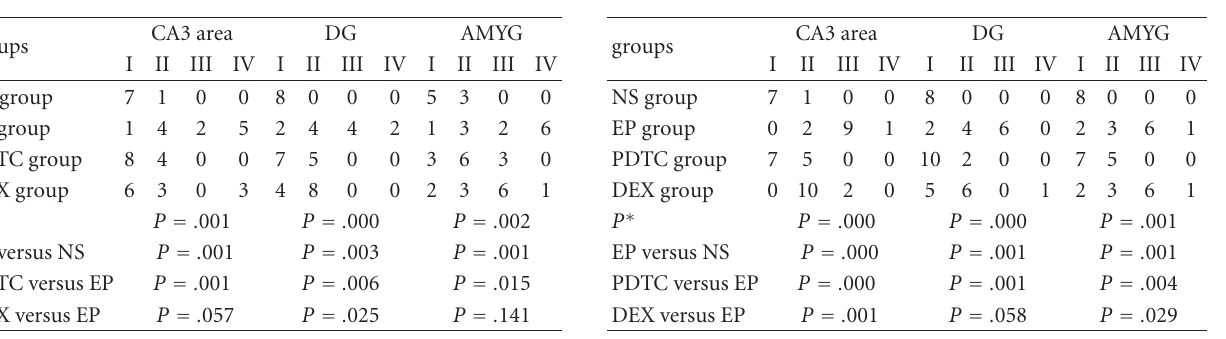
Table 2: P-gp expression in the rat brain of each group (the number of